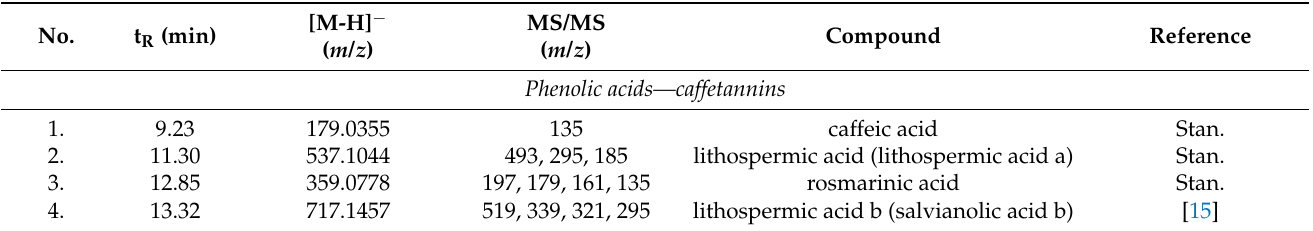
Table 1. Chemical profile of peppermint leaf dry extract confirmed by